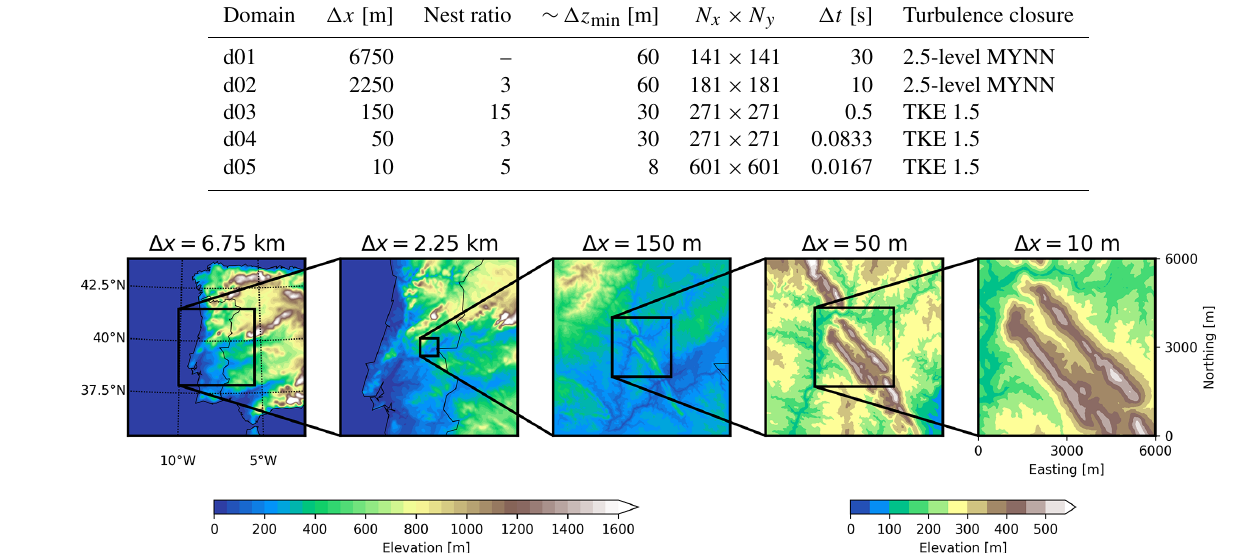
Figure 3. Topography of domains used in the multi-scale simulation centered over the Perdigão site. The five domains have resolutions of 6.75km, 2.25km, 150m, 50m, and 10m. Dimensions of each domain and other configuration information are included in Table